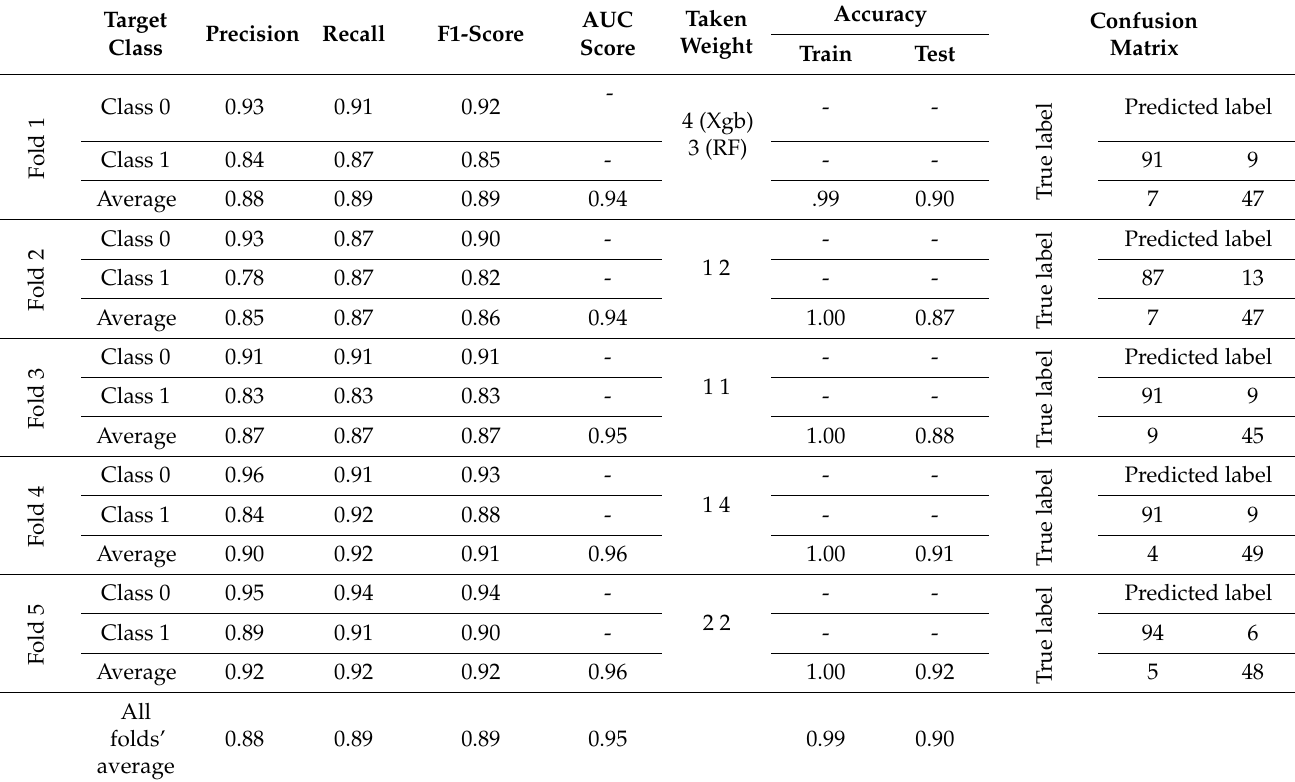
Table A7. Ensemble model’s performance for the five-fold